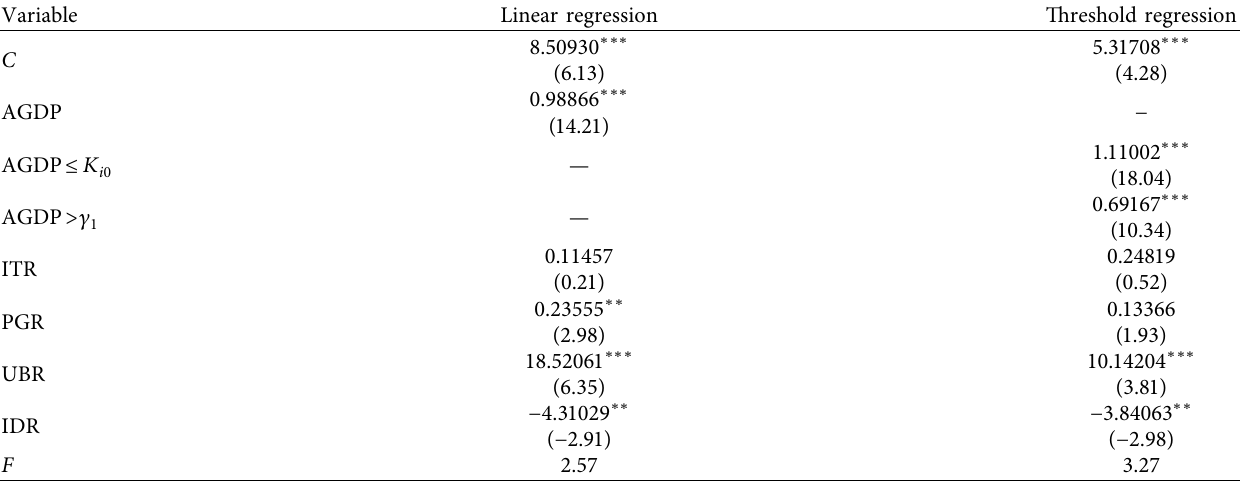
Table 8: Parameter estimation results with economic development level as threshold variable.